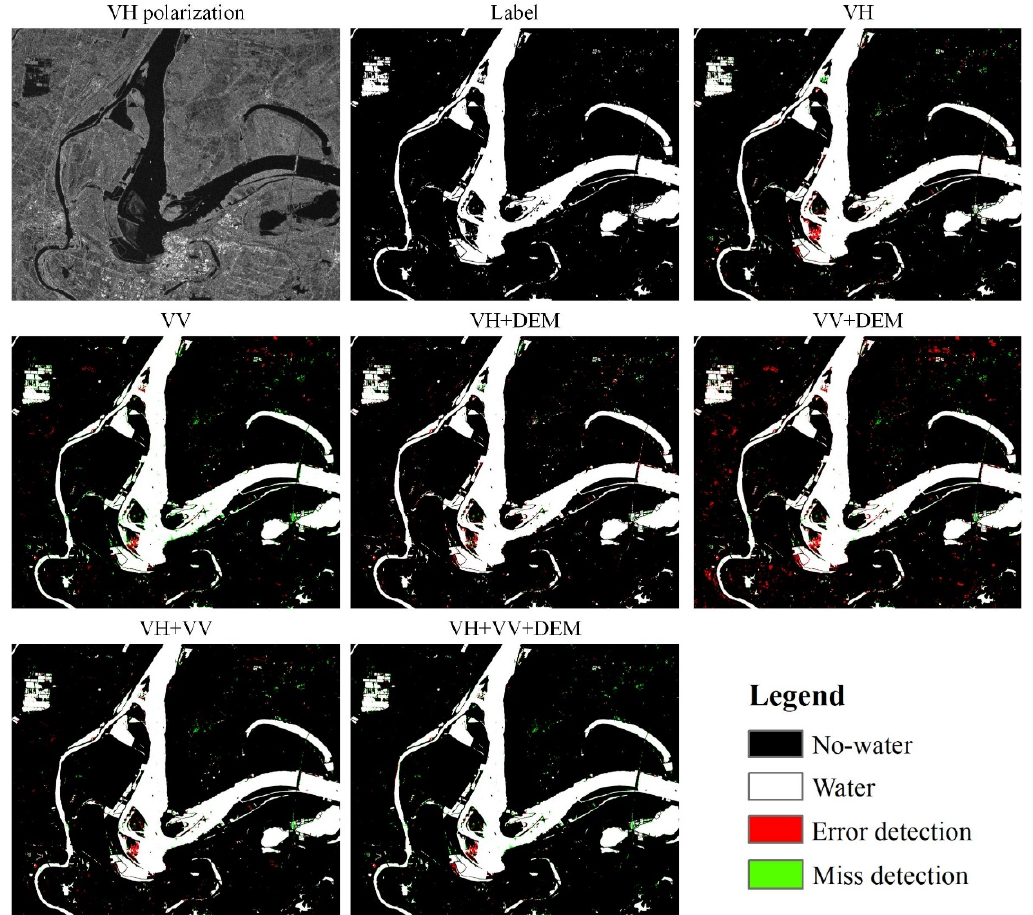
Figure 8. Flood mapping results of 2688 × 2248 images derived with UNet with the test dataset 2.